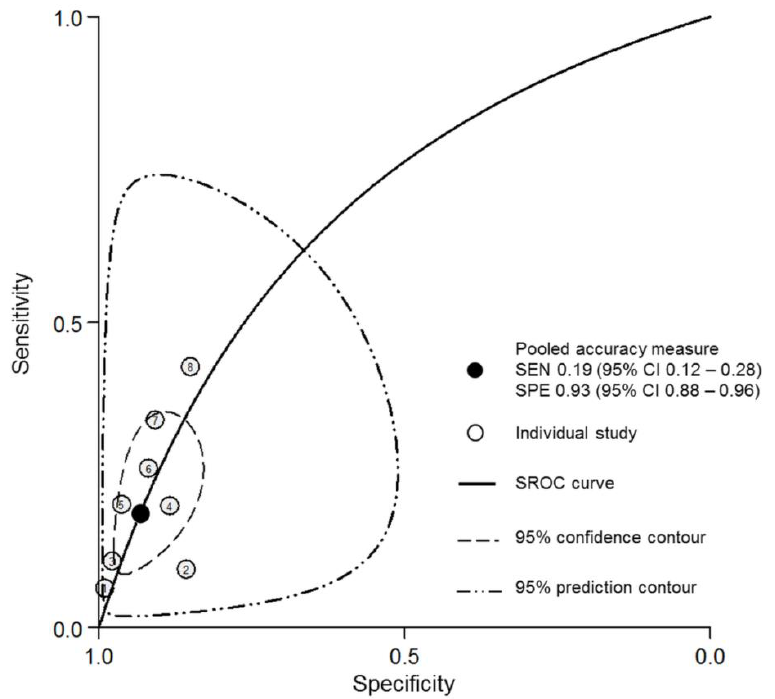
Figure 3. SROC curve for anti-DFS70 antibodies to exclude SARD in patients with a positive ANA test result. ANA, anti-nuclear antibody; SARD, systemic autoimmune rheumatic disease; SEN, sensitivity; SPE, specificity; SROC curve, summary receiver operating characteristic curve.